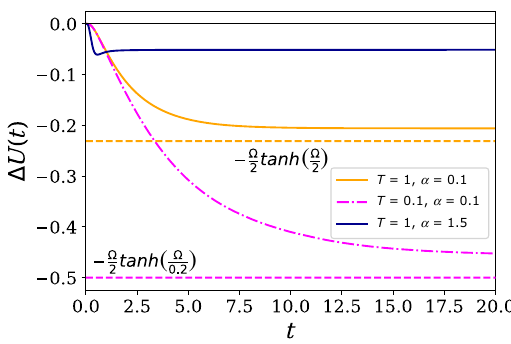
(cid:3)ˆ FIG. 6. Variation of internal energy of the system (cid:6) U ( t ) as a FIG. 4. Expectation value S x (cid:4) ( t ) for the spin-boson model at function of time for temperature T = 1, where the solid blue line weak coupling and high temperature for three different initial is for α = 1.5 and the solid orange line is for α = 0.1, and tem- states of the system. The figure shows a comparison between perature T = 0.1, where the dash-dot line is for α = 0.1. Dashed the numerical results (solid lines) and the results obtained in the lines represent the total internal energy change of the system in Born-Markov and weak-coupling approximation with the same the Markovian regime, − ((cid:15)/ 2 ) tanh ((cid:15)/ 2 T ) , for T = 1 (dashed parameters (dash-dot lines of the same color as the correspond- orange line) and T = 0.1 (dashed magenta line). The parameters ing initial states). The environment parameters are set to T = 5, controlling the numerical accuracy are K (cid:6) = 5, (cid:6) = 0.01 and = 5. The parameters controlling the numerical α = 0.1, and ω C p = 100. For all the plots, ω C = 5. accuracy are K (cid:6) = 5, (cid:6) = 0.01, and p = 100. value − ((cid:15)/ 2 ) tanh ((cid:15)/ 2 T ) predicted by Eq. (48), and